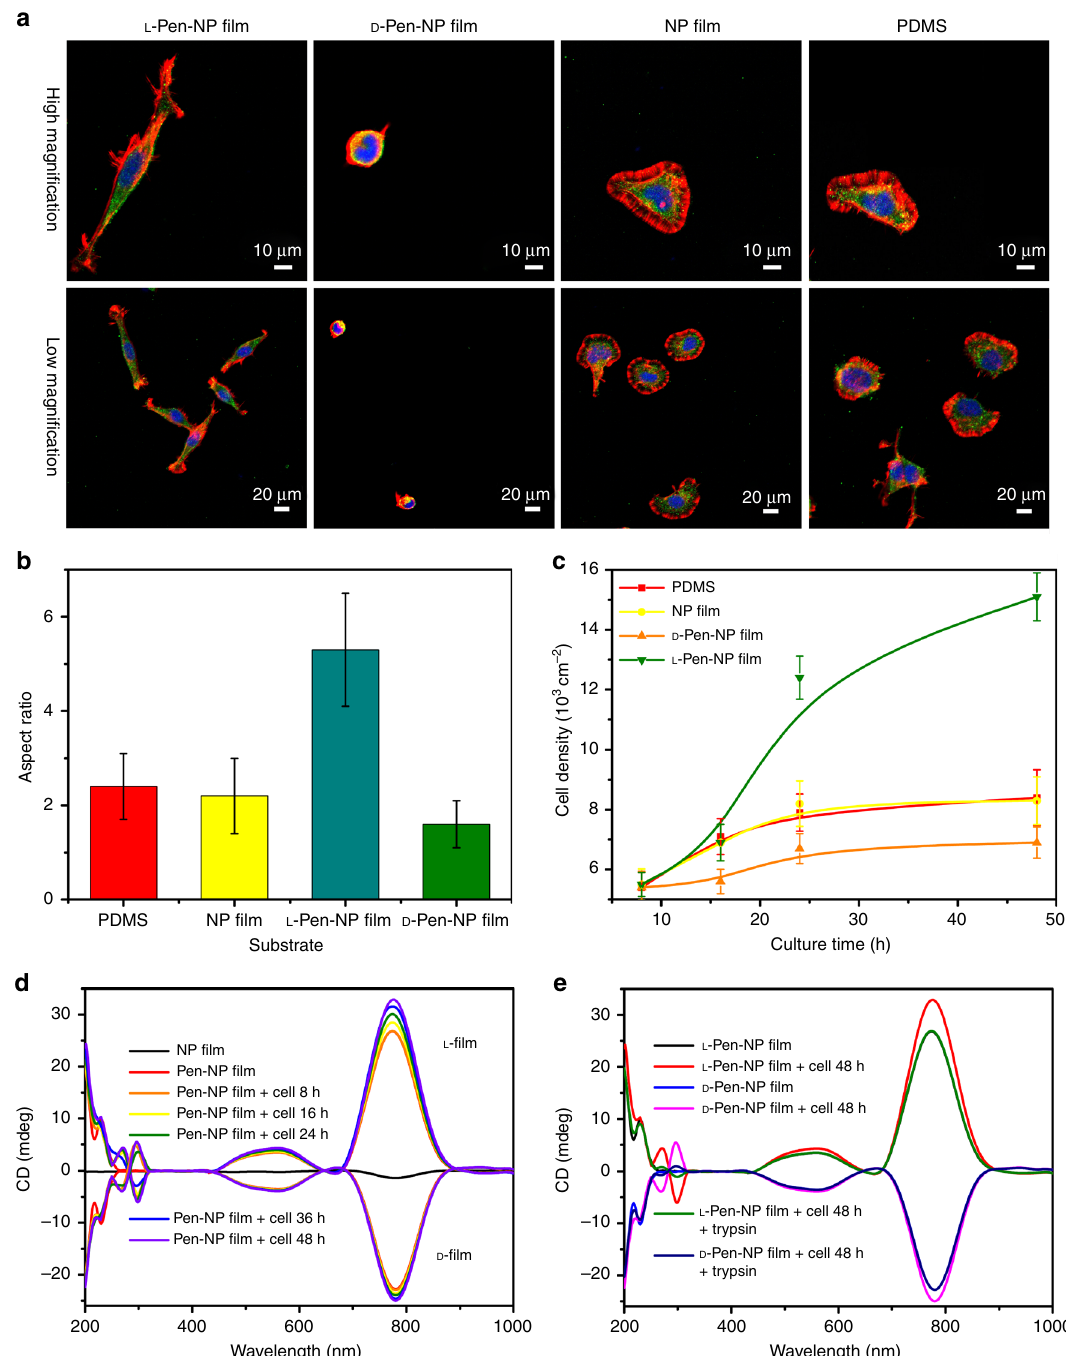
Fig. 3 Characteristics of NG108-15 cells grown on different substrates. a Confocal images of NG108-15 cell grown on different substrates (red, actin; green, vinculin; blue, nucleus) for 8 h. The scale bars of high-magni fi cation images are 10 μ m, and scale bars of low-magni fi cation images are 20 μ m. b Aspect ratio of NG 108-15 cells cultured on different substrates. c Cell densities of NG108-15 cells cultured on varies substrates for different time. d CD spectra of L - or D - P en-NP fi lm incubated with NG 108-15 cell for different time. e CD spectra of L - or D - P en-NP fi lm incubated with NG 108-15 cell for 48 h before and after treating with trypsin – EDTA solution. The error bars correspond to the standard error of the mean ( n =